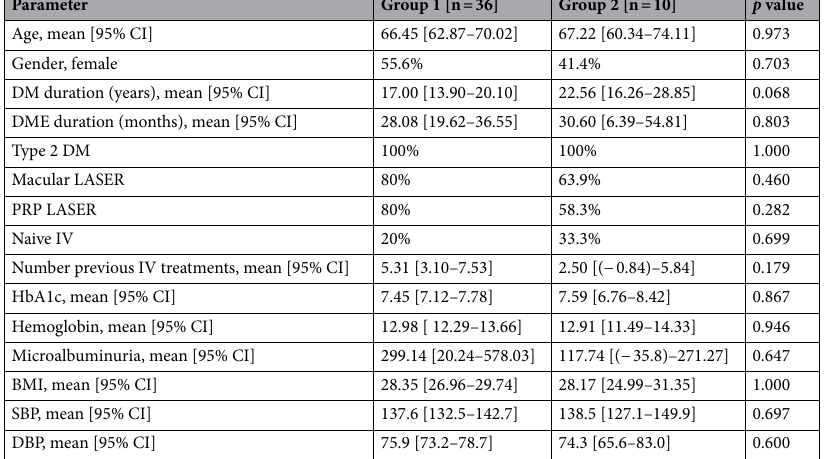
Table 1. Baseline characteristics. Group 1 = non vitrectomized; Group 2 = vitrectomized; 95% CI = 95% Confidence interval; DM = Diabetes mellitus; DME = diabetic macular edema; macular LASER = Prior focal- grid photocoagulation treatment in the study; PRP LASER = Prior panretinal photocoagulation treatment in the study eye; IV = intravitreal, naïve IV = no prior anti-VEGF intravitreal treatment in study eye; BMI = body mass index, SBP = systolic blood pressure, DBP = diastolic blood